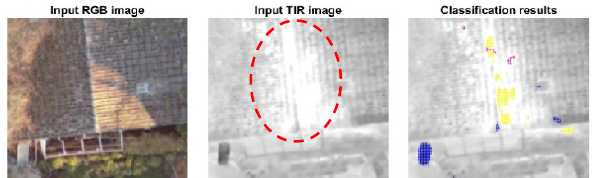
Figure 9: False classification by DST caused by the shadows.